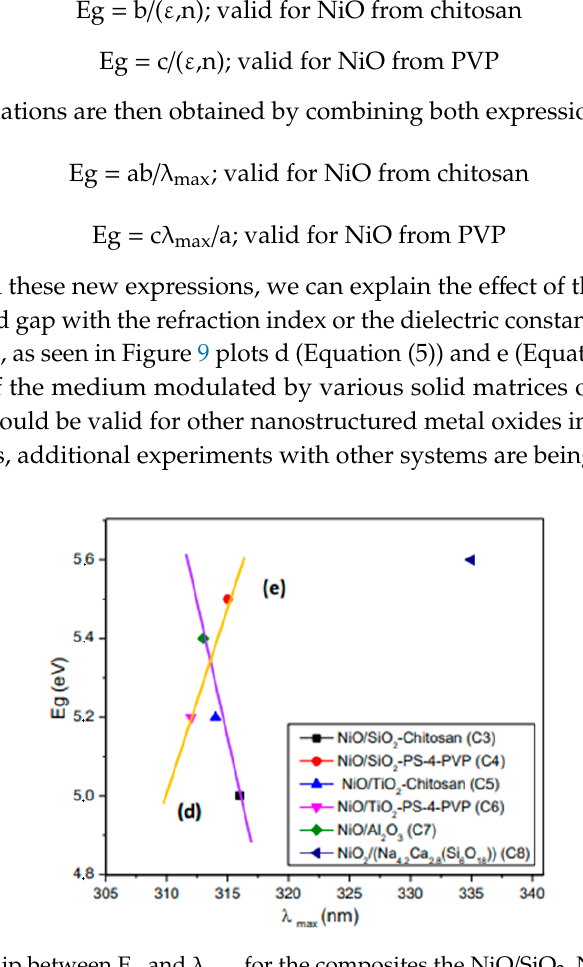
Figure 9. Relationship between E g and λ max for the composites the NiO / SiO 2, NiO / TiO 2 , NiO / Al 2 O 3 , and NiO / Na 4.2 Ca 2.8 (Si 6 O 18 ).